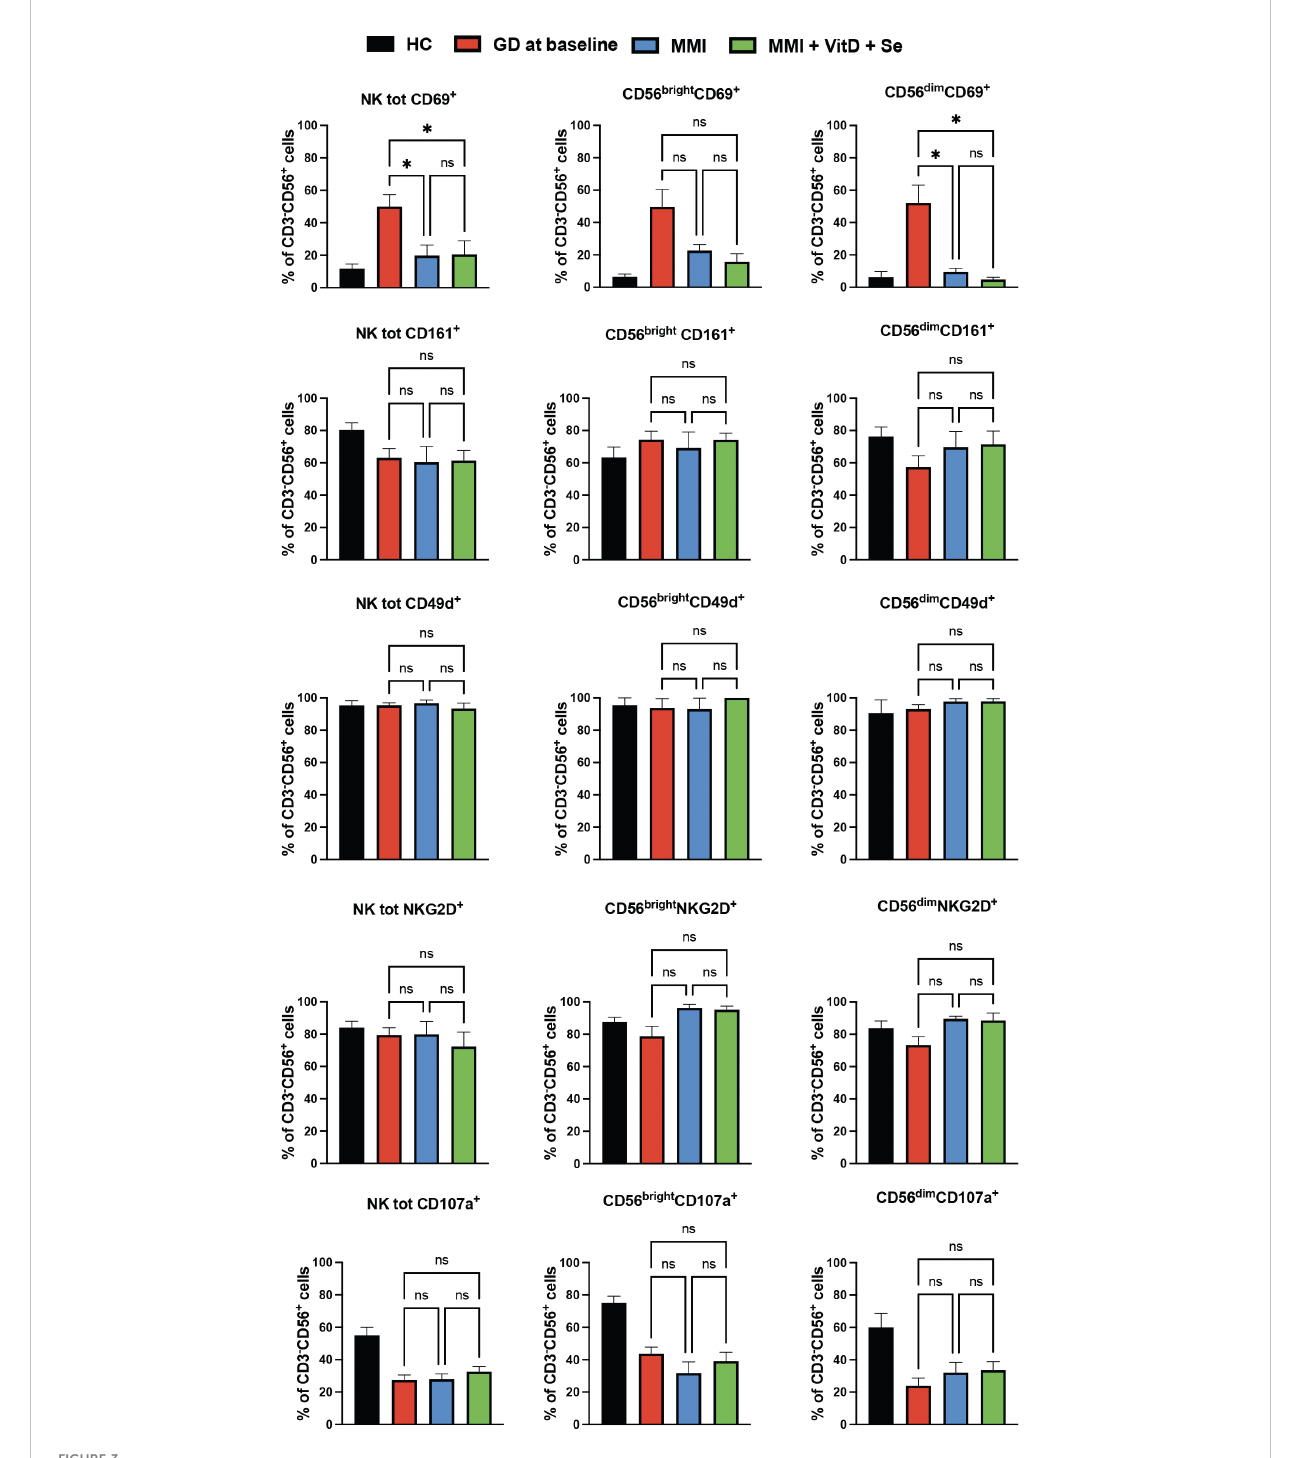
FIGURE 3 Phenotypic (CD69, CD161, NKG2D, CD49d) and functional (CD107a) data of natural killer cells from Graves ’ disease patients, at baseline, and after six months of treatment, divided by group of intervention Twenty- fi ve age and sex healthy donors served as control group. Histograms showed the percentages of NK cells expressing activating (CD69+), inhibitory (CD161+, NKG2D+) receptors, the integrin CD49d and having cytotoxic ability (CD107a+). Data were shown as mean SEM (standard error of the mean), student t-test, *p<0.05. GD, Graves ’ disease patients; MMI, methimazole. NS, not statistically signi fi